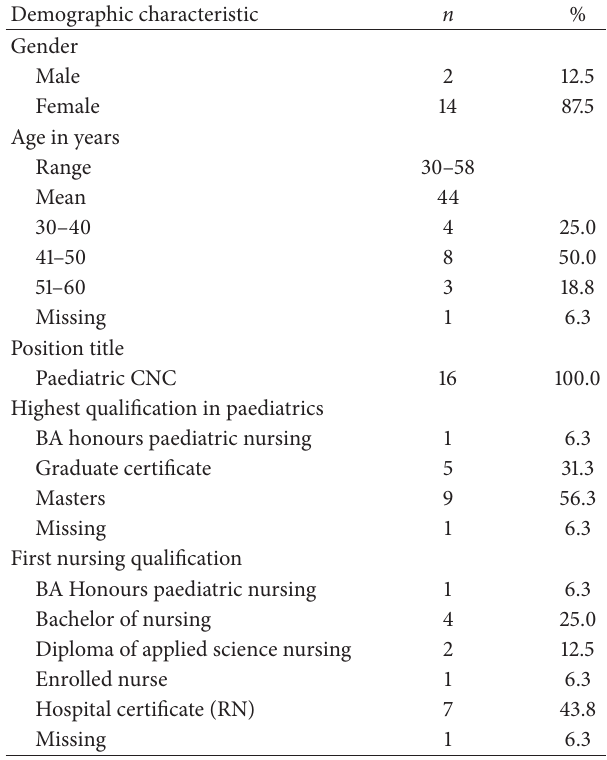
Table 1: Demographic characteristics of participants in NGT ( 𝑛 = 16